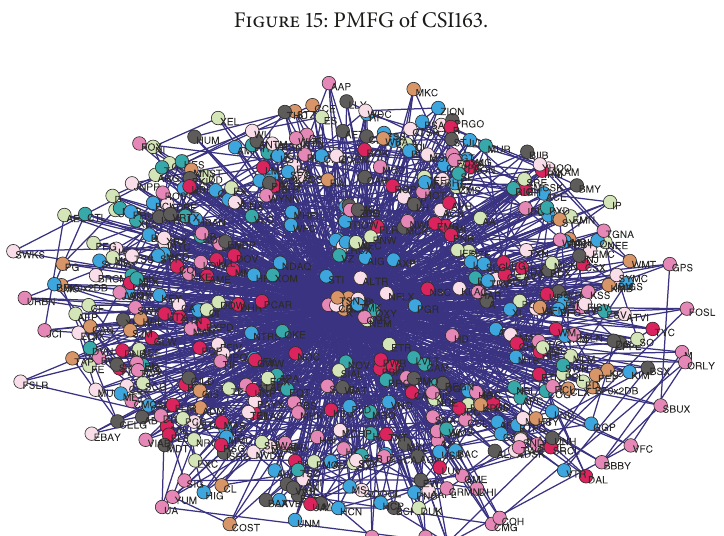
Figure 15: PMFG of CSI163.